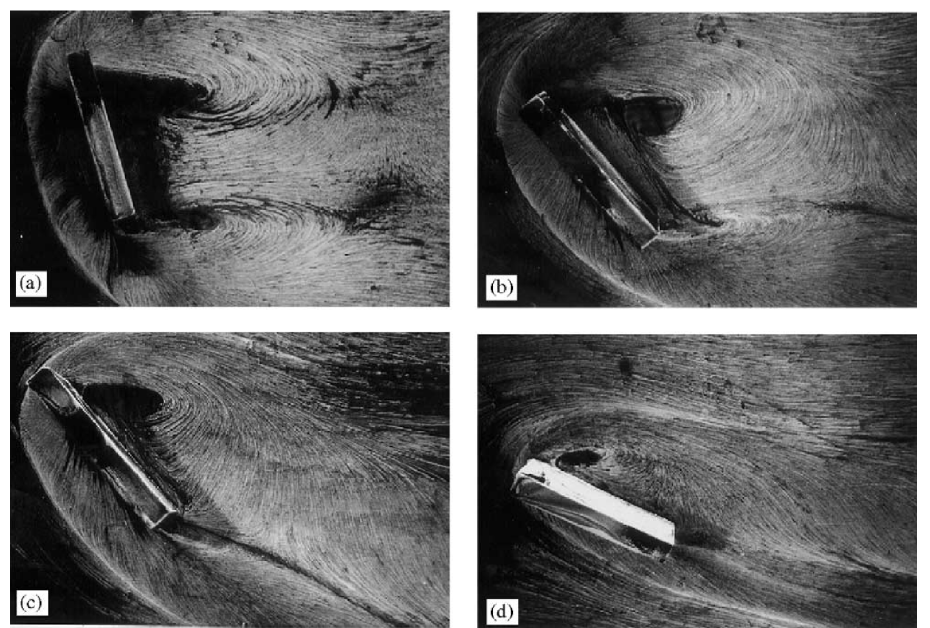
Figure 9. Oil-film visualizations of the vortical structures around a wall-mounted obstacle with b / h = 2 and w b / h = 0.29. The following incidence angles are shown: ( a ) AOI = 15 ◦ , ( b ) AOI = 30 ◦ , ( c ) AOI = 45 ◦ and ( d ) AOI = 60 ◦ . Reprinted from Ref. [132], with permission of the publisher